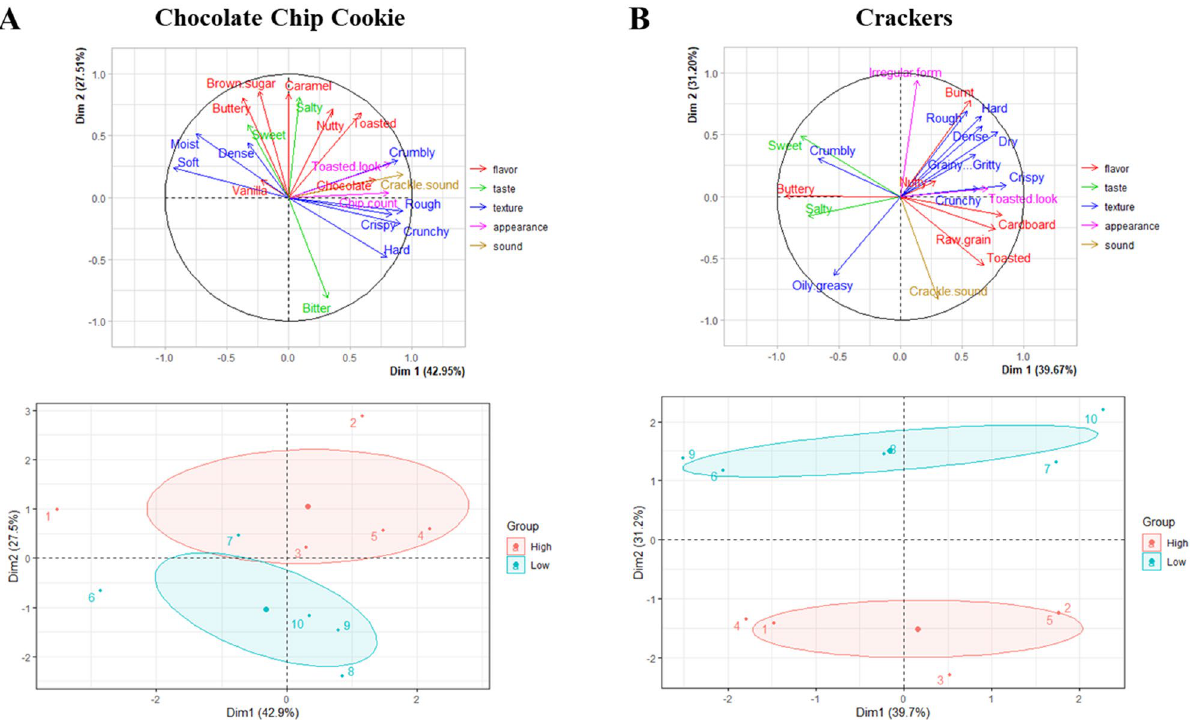
Figure 5. Multiple Factor Analysis plot showing individual term ranks between groups by product. High and low touch sensitivity groups used different terms to rank the product space, but differences were dependent on the product space being profiled ( A , chocolate chip cookies, and B ,